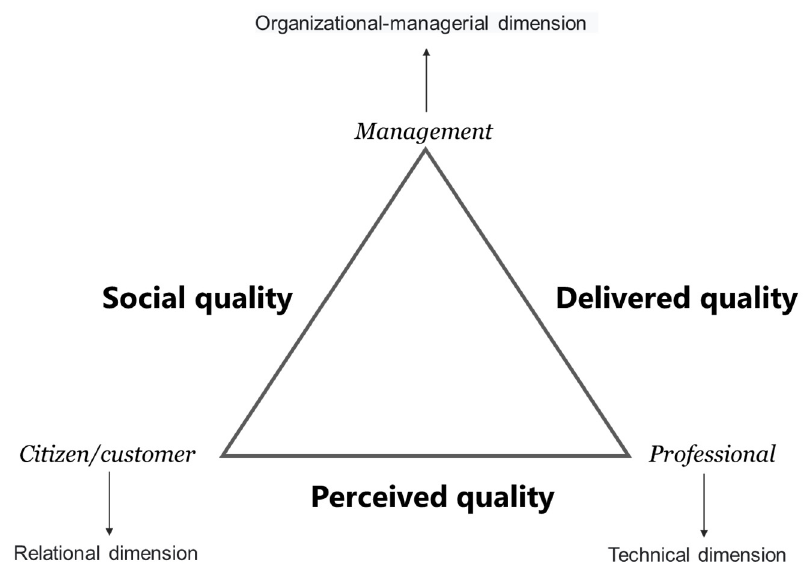
Figure 1. Triangle of quality (the dimension concept will be defined in the following).